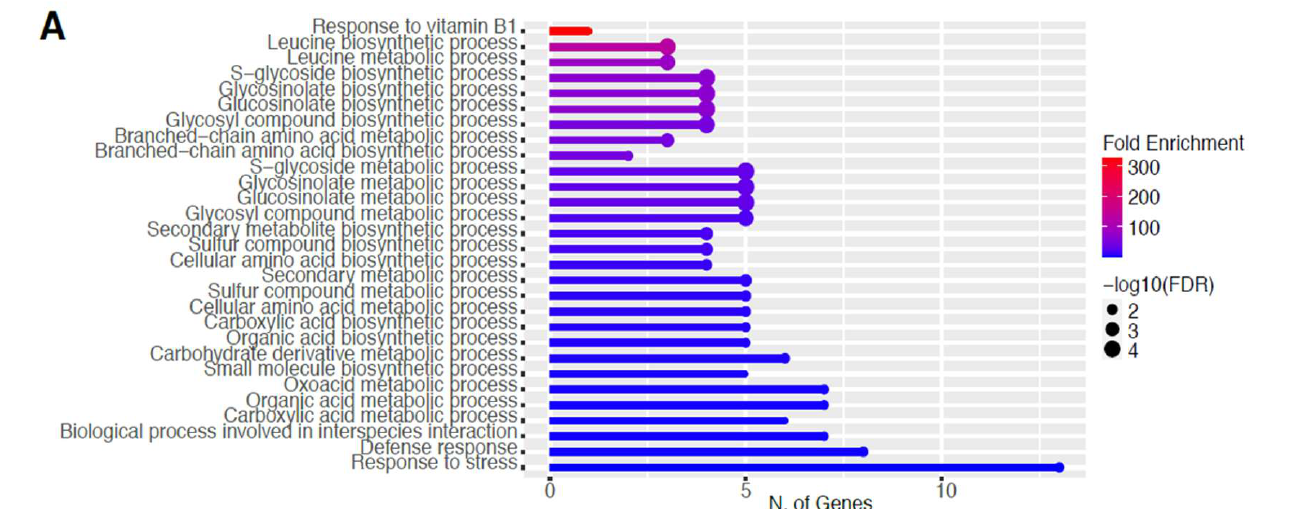
Figure 6. Gene enrichment analysis for downregulated genes after 60 s plasma treatment. Lollipop diagrams provide information about GO fold enrichment, significance (FDR in log10), and number of genes in each pathway. From top to bottom, GO categories are in the following order: ( A ) biological process, ( B ) cellular component, ( C ) molecular function, and ( D ) KEGG pathway.